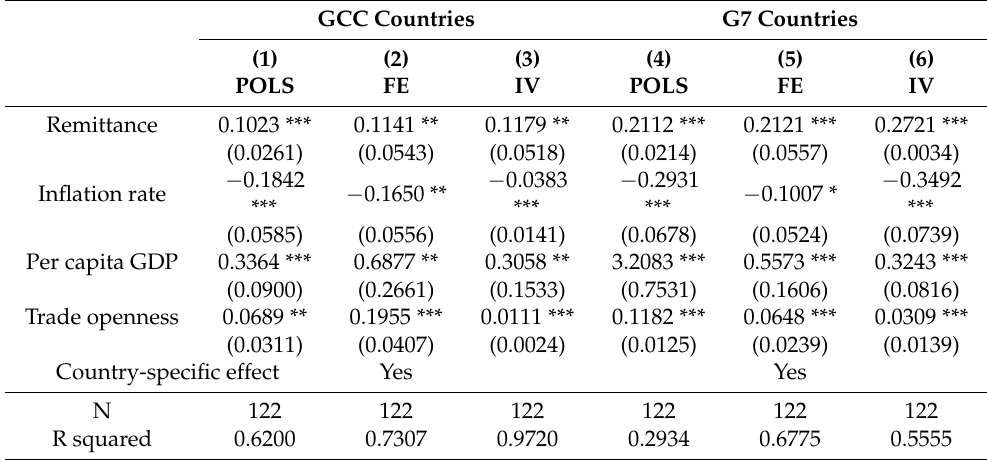
Table 7. Impact of remittance on gross domestic savings to GDP